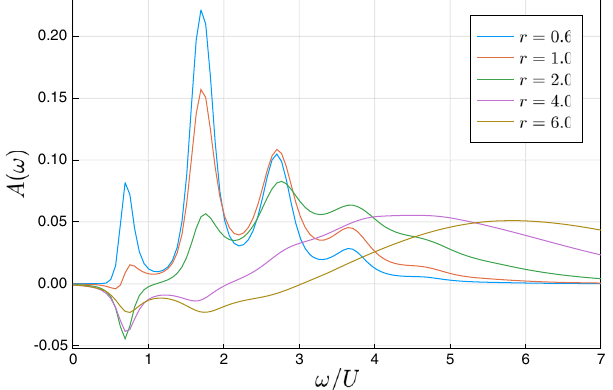
FIG. 6. Local spectral function A ð ω Þ obtained from DMFT NCA for different values of the pump/loss ratio r at fixed J=U ¼ 0 . 2 and z ¼ 6 . Upon increasing r , the lowest Hubbard band flips sign and a region of NDOS emerge at positive frequencies, up to ω ¼ Ω 0 ð r Þ , where the spectral function vanishes, A ð Ω 0 Þ ¼ 0 . The spectral range of NDOS increases 14 . with r . Parameters: dim H ¼ Hubbard band flips sign and a region of NDOS appears in a positive frequency range [139].